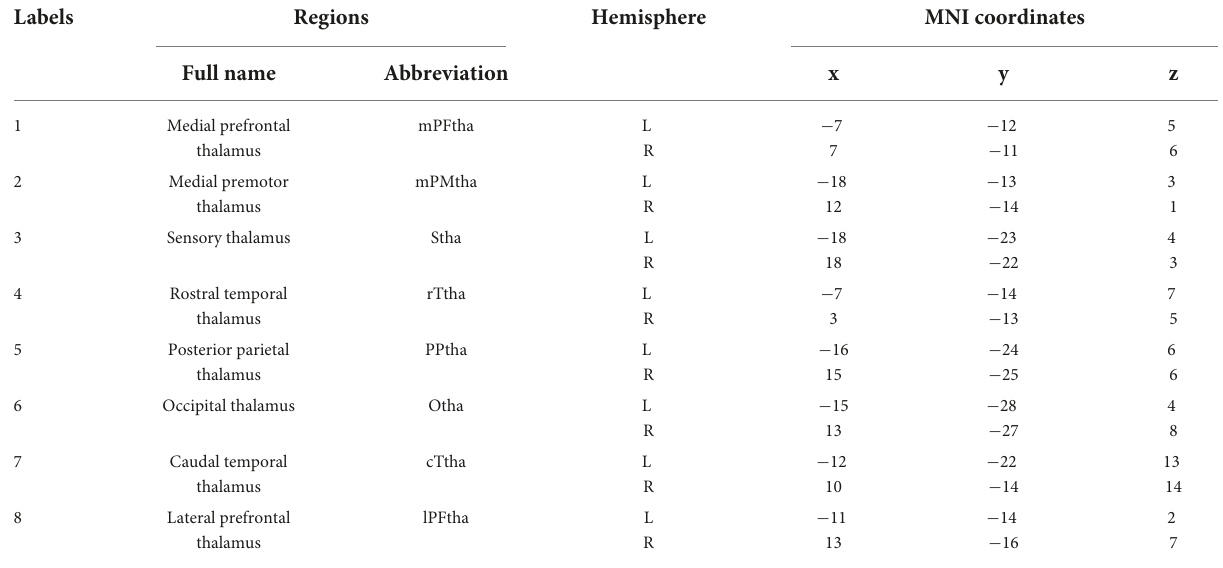
TABLE 1 Regions of interest within the thalamus.